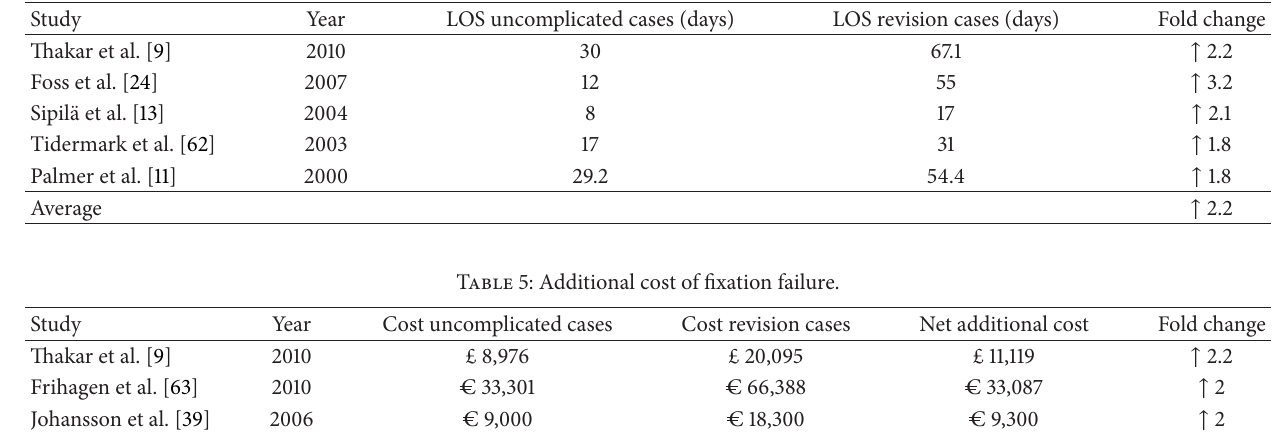
Table 4: Impact of fixation failure on length of stay (LOS).